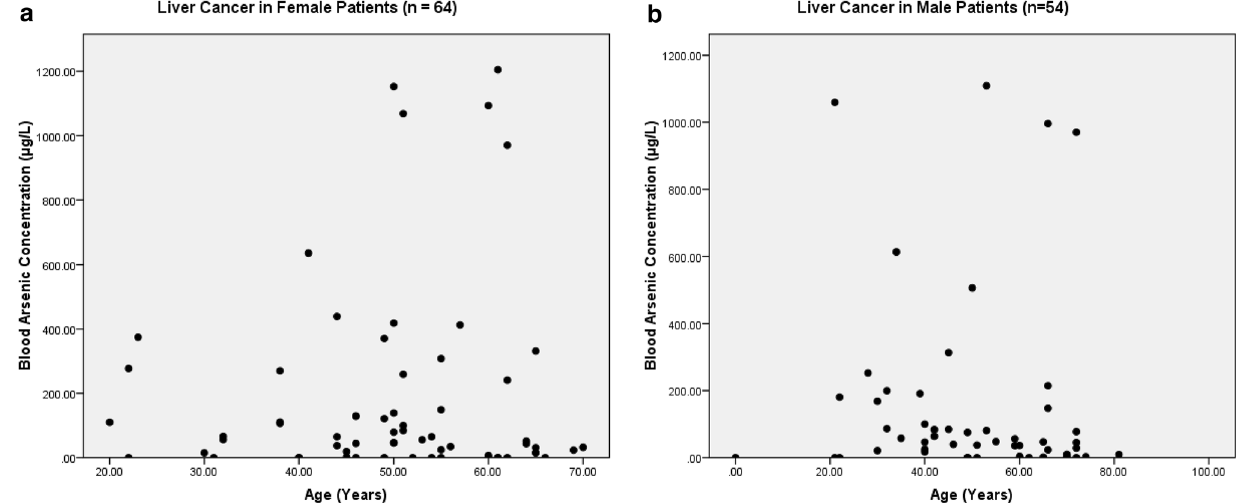
Figure 12. The correlation coefficient between blood arsenic levels and age of the female vs male liver cancer patients (P < 0.05).